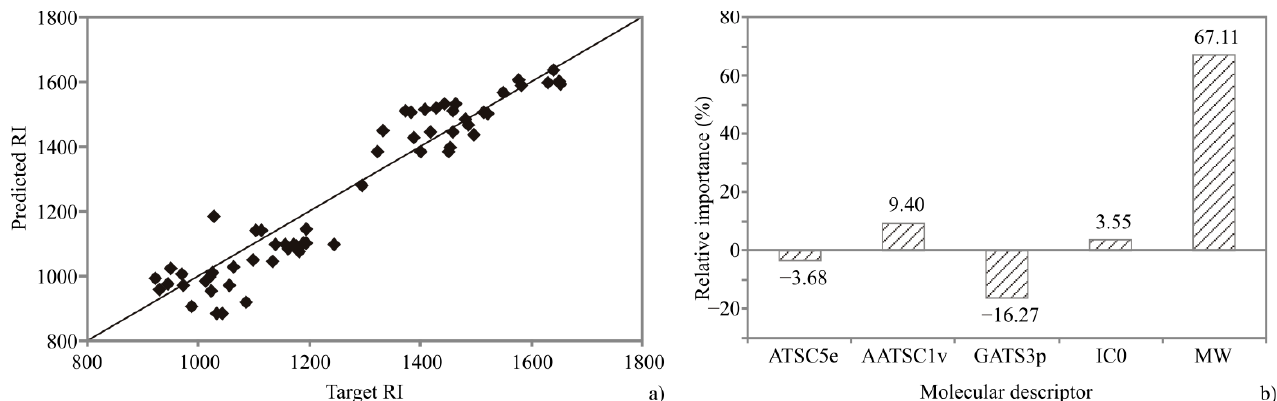
Figure 4. ( a ) Comparison of experimentally obtained RIs with ANN predicted values; ( b ) The relative importance of the molecular descriptors on RI, determined using Yoon interpretation method.